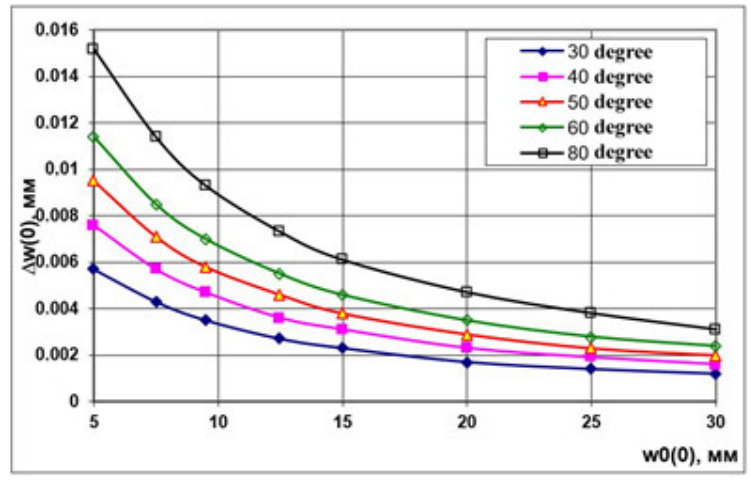
Figure 11. IS screen electrode additional deflection (∆w(0)) as a function of initially designed deflec- tion (w 0 (0)) at different levels of temperature drop along SE radius.